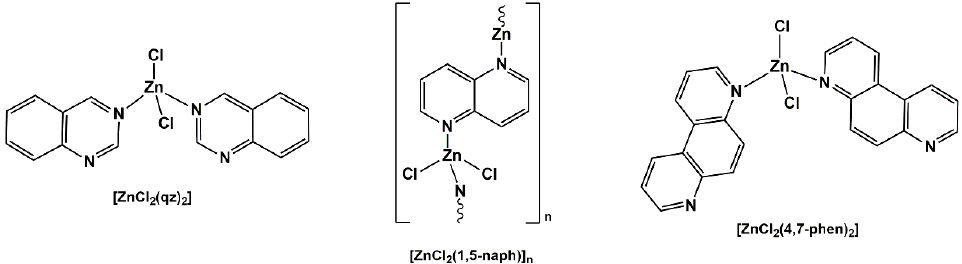
Figure 2. Structural formulas of zinc(II) complexes which showed good anti- Candida activity (qz is quinazoline, 1,5-naph is 1,5-naphthyridine and 4,7-phen is 4,7-phenanthroline) [24].